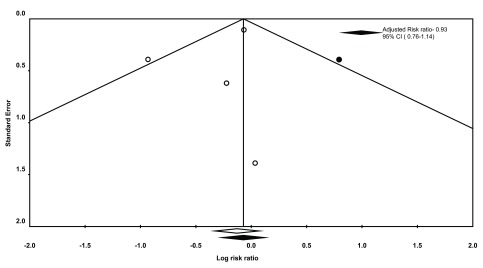
Filled funnel plot using the trim and fill method for risk of non-respiratory complications: imputed studies - ●, observed studies - ○,
CI – confidence interval.